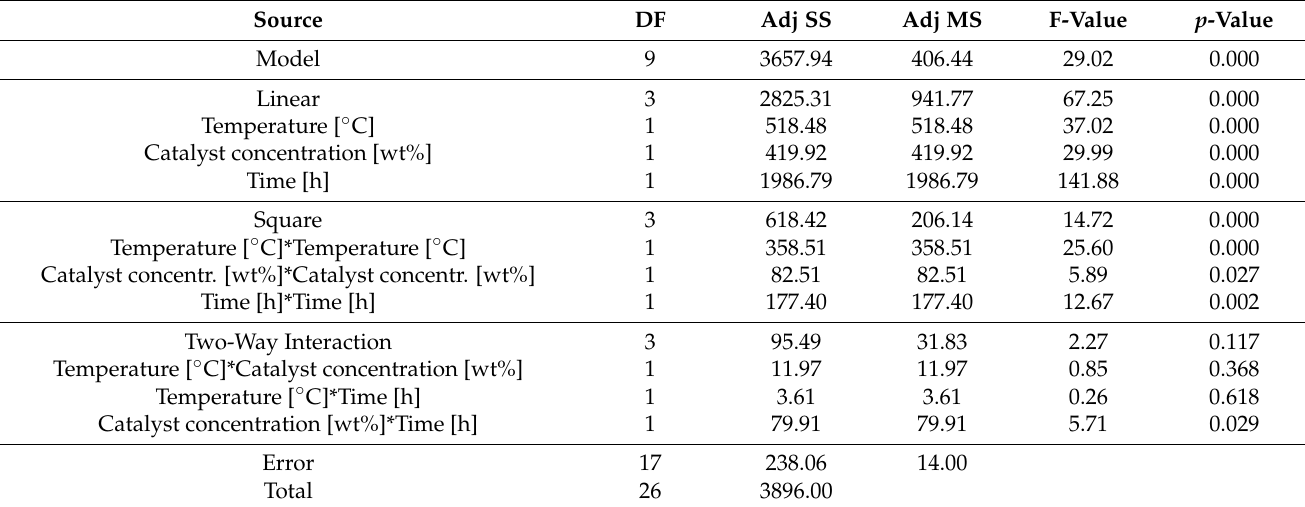
Table 4. Analysis of variance of NE